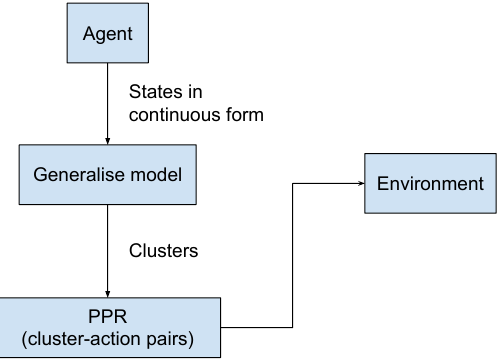
Figure 3. Broad advice transforms continuous states into finite clusters. Hence, the state–action pair becomes the cluster–action used in the PPR